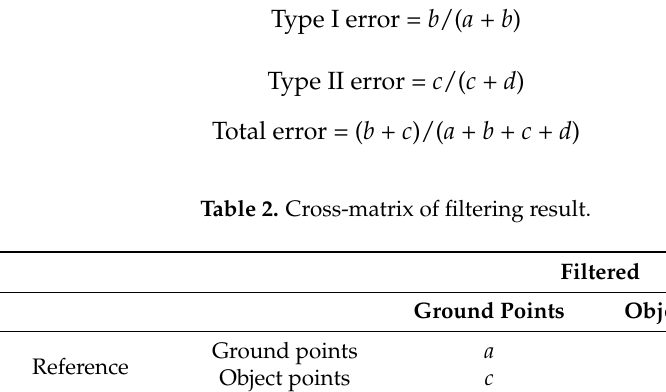
Figure 8. Comparison of type II errors for filtering ISPRS datasets. Figure 9. Comparison of total errors for filtering ISPRS datasets. The comparison shows that the proposed method tends to suppress omission error, and obtain a relatively lower average total error. However, the commission error is high compared to the other methods. Thus, our method classifies more non-ground as ground points than the other two methods, while fewer ground points are removed from the dataset as they are classified as non-ground points. In the present case, our filtering method is biased in favor of minimizing Type I errors as shown in Figure 10.